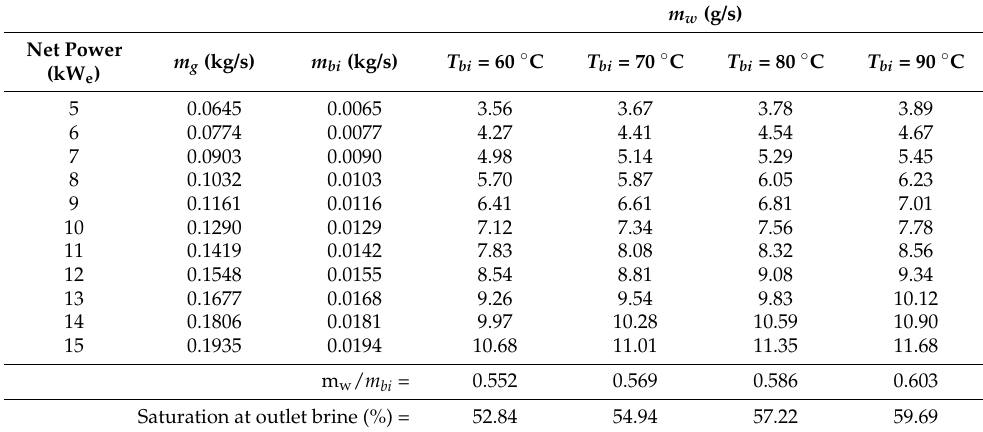
Table 7. Water evaporated for SMGT; Pressure Ratio = 3.5, T gi = 256.61 ◦ C, S bi = 0.07 kg/kg, S sat = 0.296 kg/kg, m g / m bi = 10.